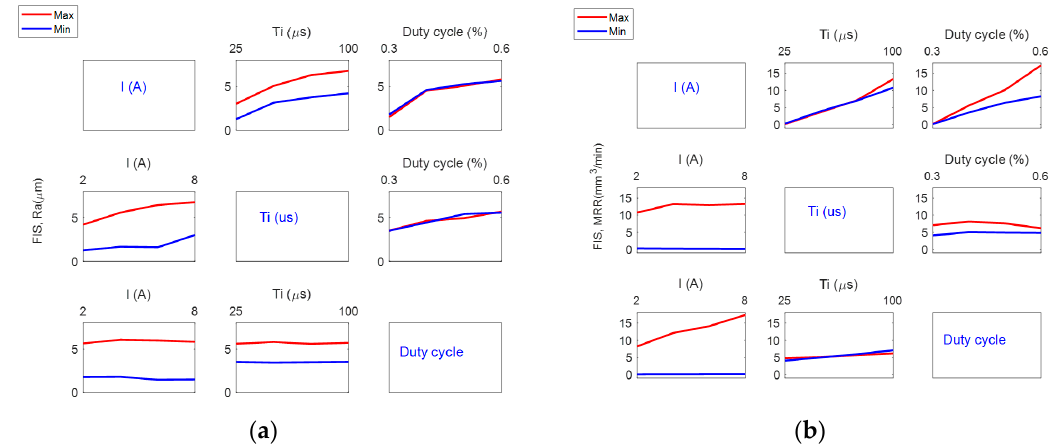
Figure 13. Interaction effects plot for ( a ) Ra and ( b ) MRR in the case of positive polarity, obtained using the FIS.